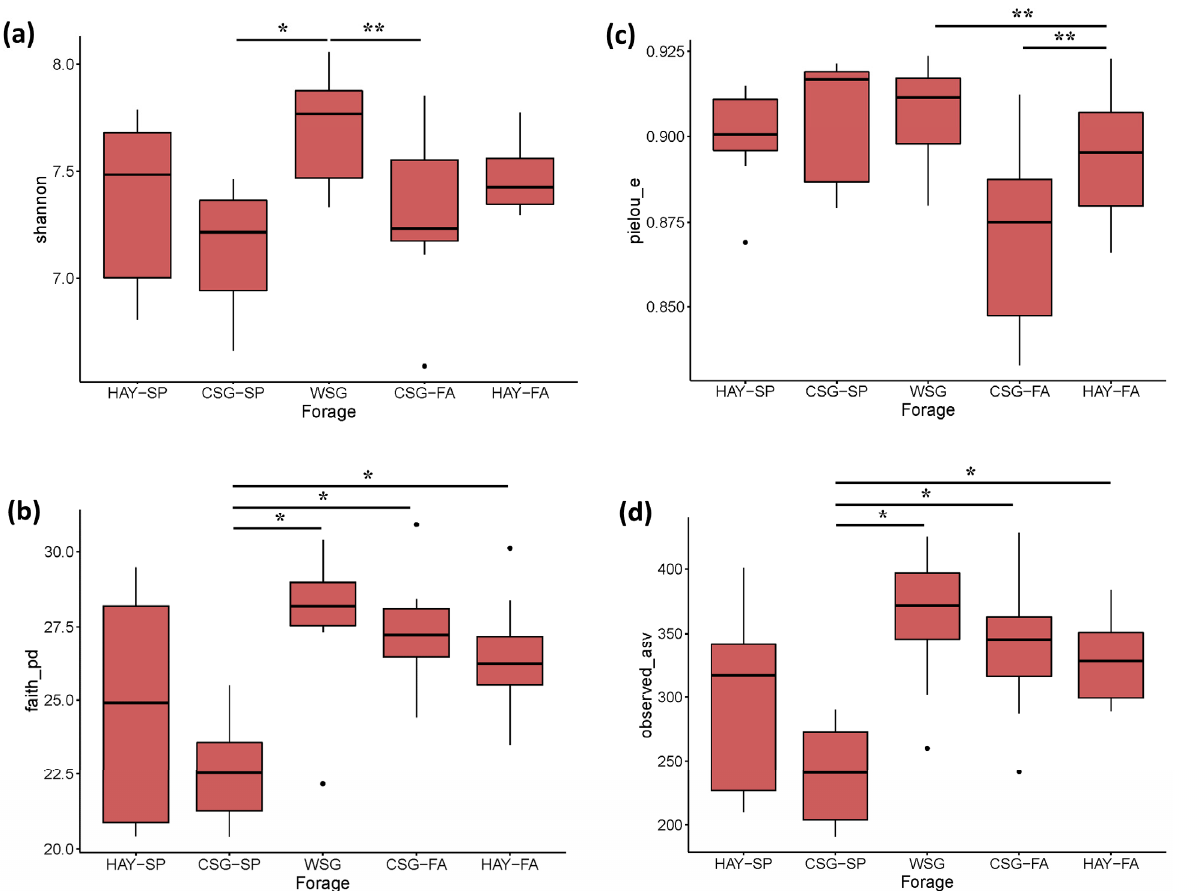
Figure 1. Fecal microbiota α -diversity across forages within an integrated rotational grazing system including: HAY-SP: initial standardized cool-season grass hay diet in the spring; CSG-SP: cool-season grass pasture in the spring; WSG: warm-season grass, either crabgrass or bermudagrass, in the summer slump period; CSG-FA: cool-season pasture in the fall; HAY-FA: final standardized cool-season grass hay diet in the fall. Shannon Diversity Index ( a ), Faith’s Phylogenetic Diversity ( b ), Pielou’s Evenness ( c ) and Observed ASV ( d ) were analyzed by Kruskal–Wallis tests with Benjamini and Hochberg FDR adjustments for multiple pairwise comparisons. A “ ⋅ ” indicates a statistical outlier in the data. A single asterisk indicates differences between forages at p ≤ 0.05. A double asterisk indicates a trend for differences between forages at p ≤ 0.10.